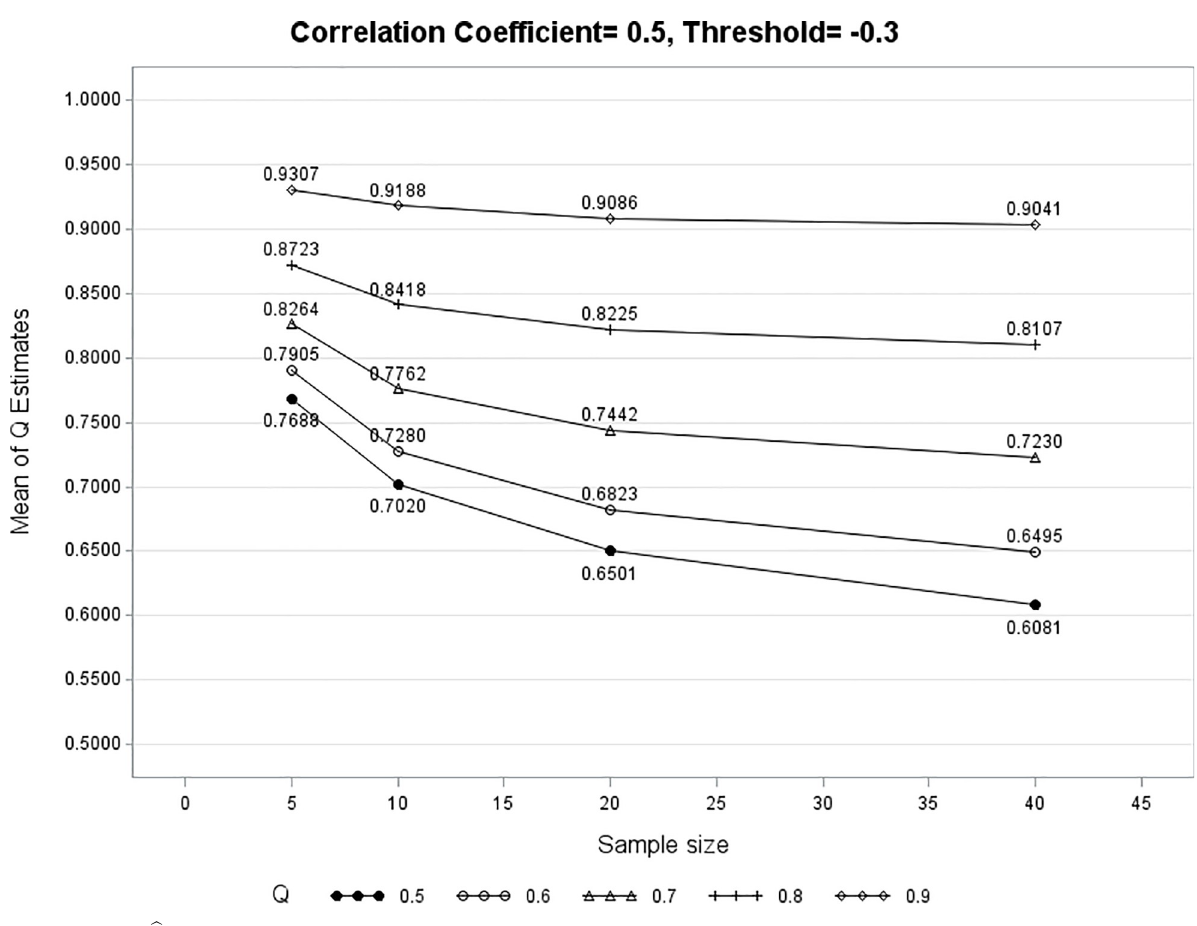
Fig 4. The mean b Q